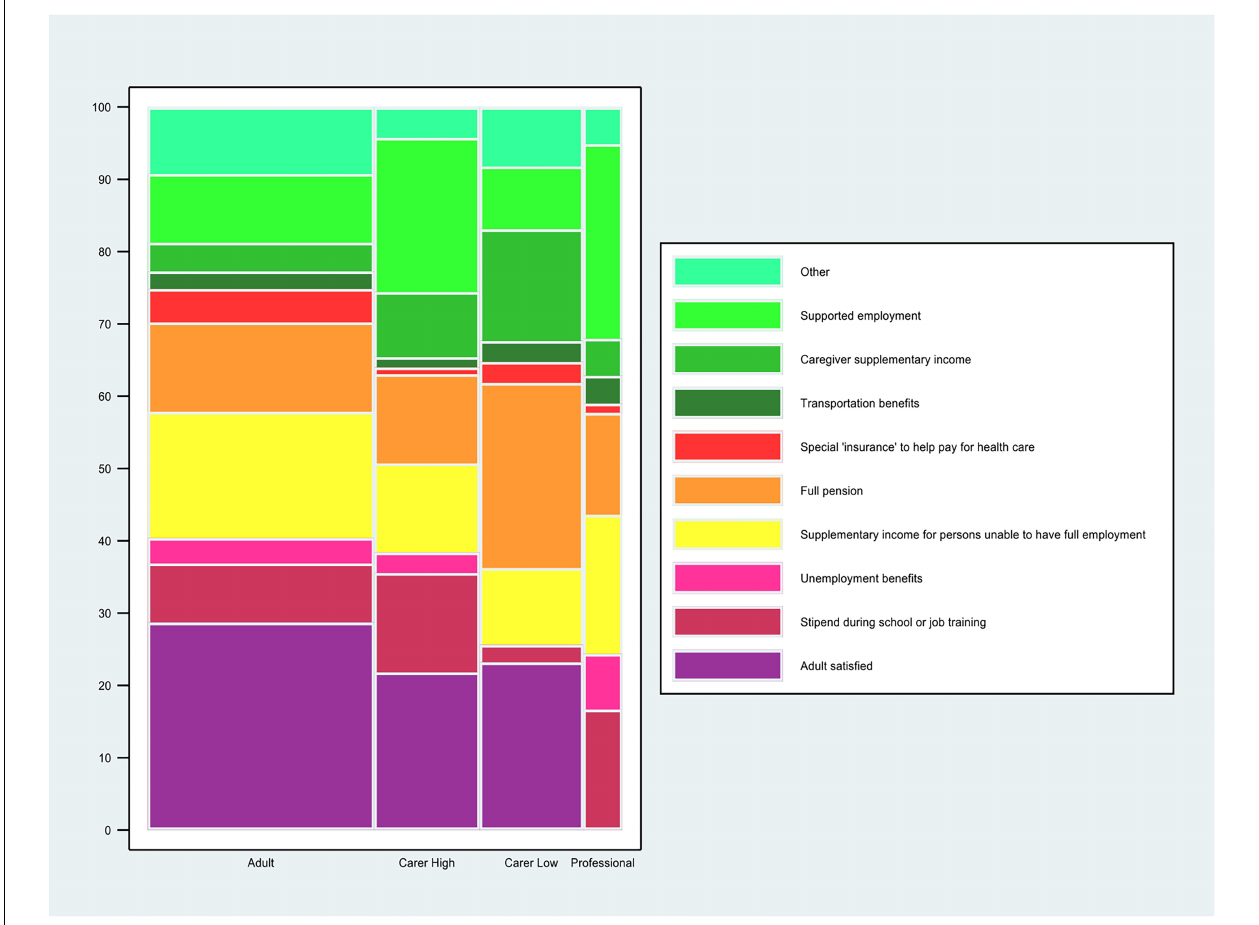
FIGURE 5 | Preferred financial service. The question for the autistic adults was: “ If you could choose a financial service that fits your needs best now, what would you choose? (Please, tick 1 box).” The question for the carers of autistic adults was: “If you could choose a financial service that fits the adult’s needs best now, what would you choose? (Please, tick 1 box).” The carers’ data are stratified by high and low level of independence of the autistic adult. The question for the professional was: “Which 2 types of financial services do you think are most needed for autistic adults in the (geographical) area where you work now? (Please, tick 2 boxes).” Professionals who selected “ I prefer not to make a choice ” are not included in the calculation of% for each of the other answer choices. The %s for the other answer choices are based on the professionals who made a choice, n = 78 (88–10 = 78). *This% is calculated on the total sample of the professionals’ responders ( n = 88). Data are for all adults and carers of